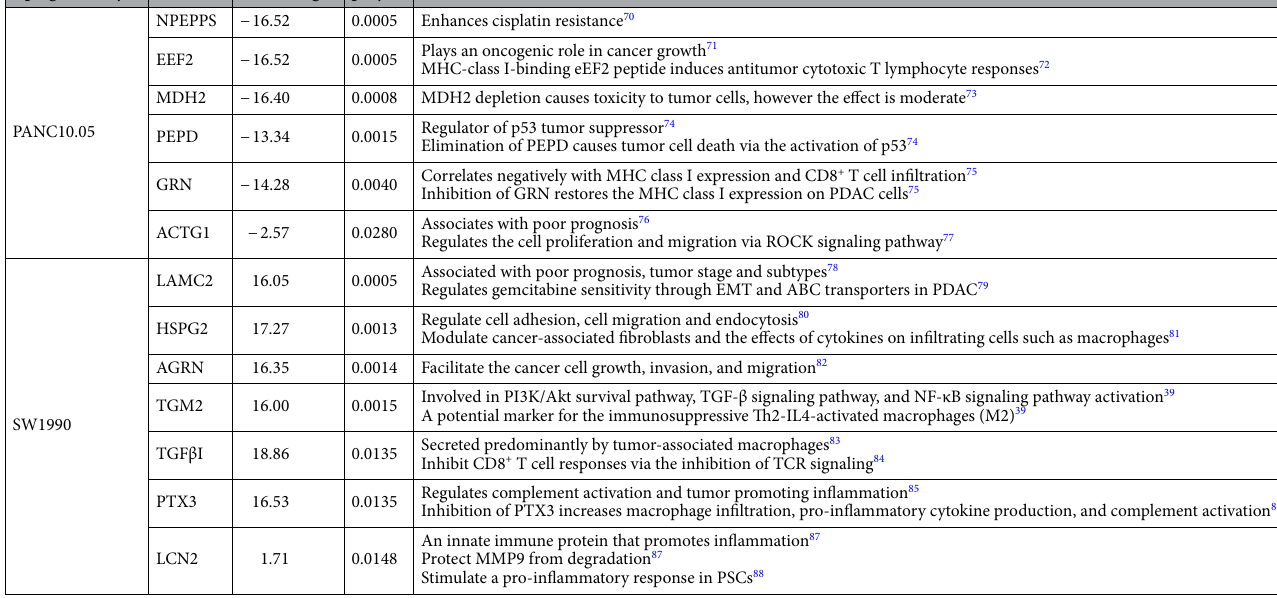
Table 1. The DEPs detected between PANC10.05 and